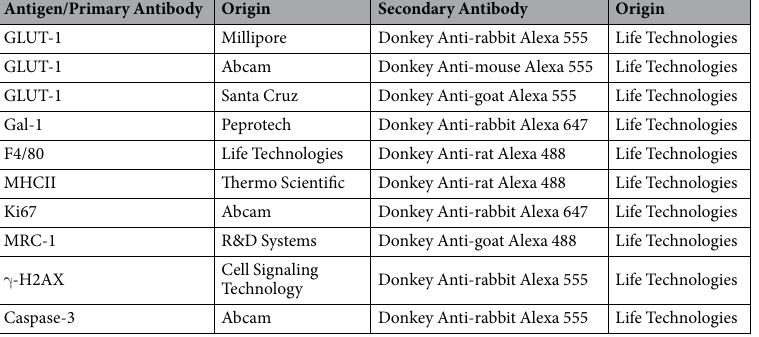
Table 2. Immunofluorescence